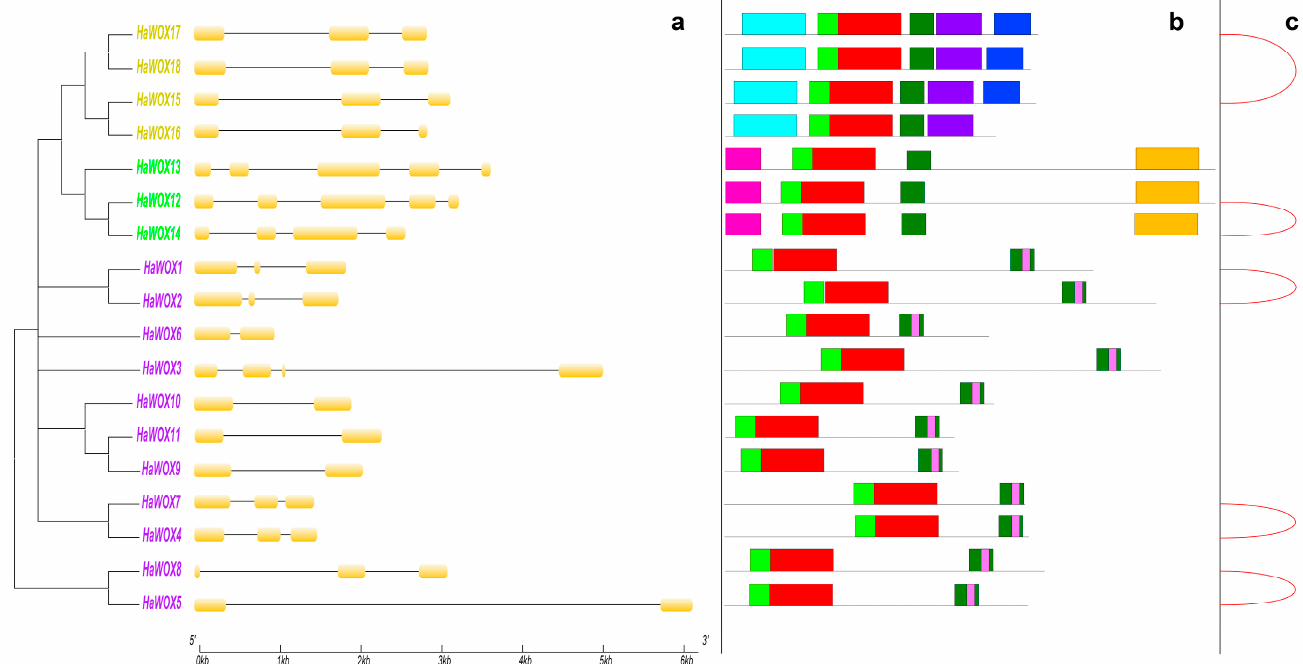
Figure 4. Phylogenetic, genomic, and structural characterization of sunflower WOX ( HaWOX ) family subdivided per ancient (yellow), intermediate (green), and WUS (purple) clades. ( a ) = exon (yellow) and intron (black dash) structure for HaWOX genes as visualized by GSDS; ( b ) = structural motifs identified on protein sequences by MEME and Clustal Omega (Table S5; Figure 5 and Figure S1); ( c ) = whole genome duplication (red arches) for HaWOX multigene family; the edge of the arch indicates the two genes deriving from the same duplication event. Colors in ( b ) are specified in Table S5.